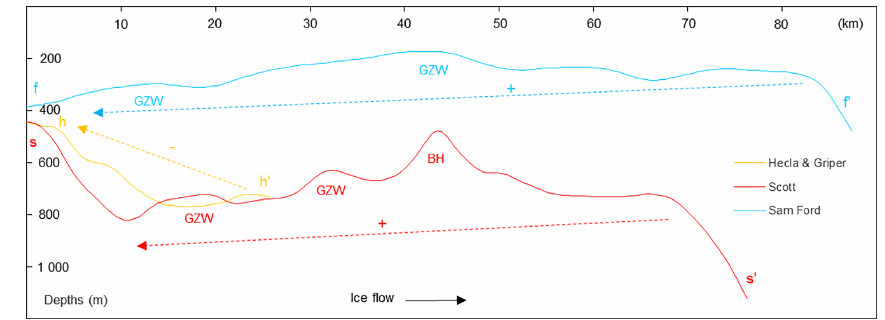
Figure 2. Longitudinal depth profile along the ice flow route for each trough. Arrow with a minus ( − ) symbol indicates a general up-ice decreasing profile of depths. Arrows with a plus ( + ) symbol indicate a general up-ice increasing profile of depths (glacial overdeepening landward). BH: bedrock high; GZW: grounding-zone wedge.